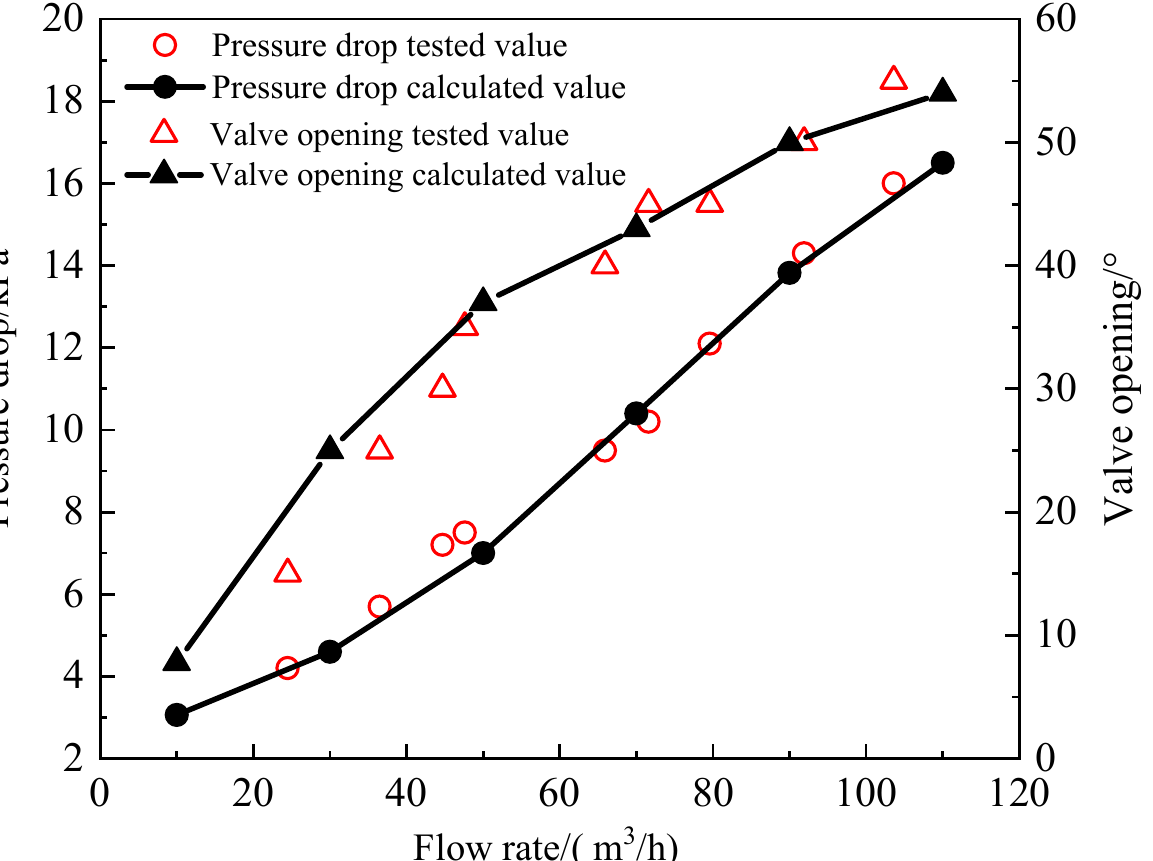
Figure 10. The relation curve between pressure drop and opening with the flow rate the dual disc valve opened.